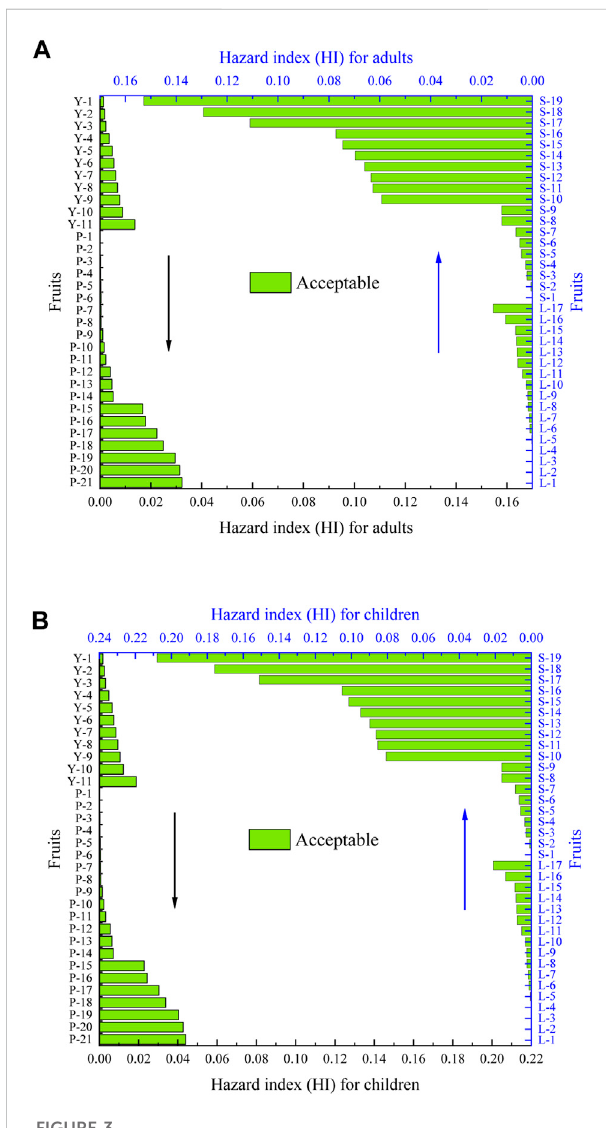
The estimated hazard index (HI) of pesticides for adults (A) and children (B) based on the consumption of the four fruit types. Letters refer to the different fruits: Y represents yellow peach, P represents pear, L represents loquat and S represents sweet spring